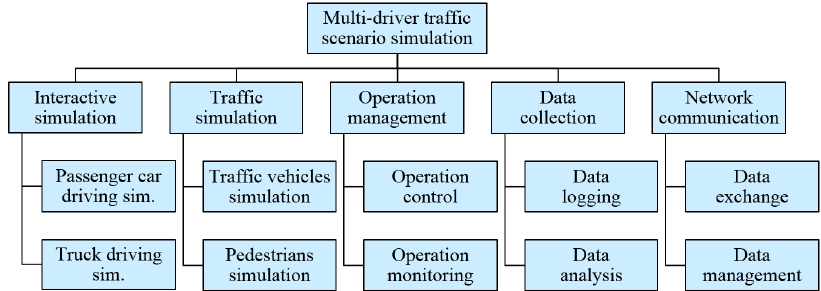
Figure 6. Example functions partial model of a networked driving simulation system.